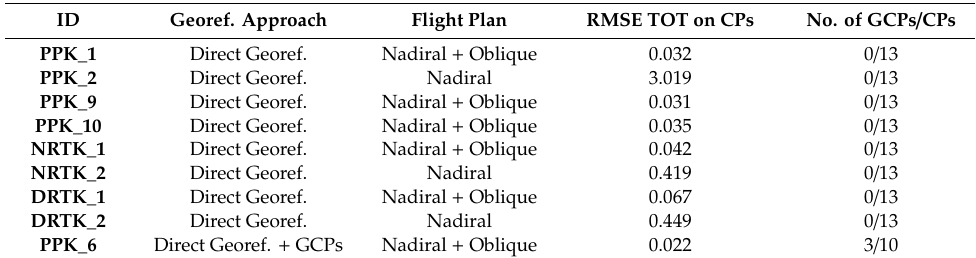
Table 15. Summary of the results of the different direct georeferencing approaches tested and the best mixed solution (one GCP only).